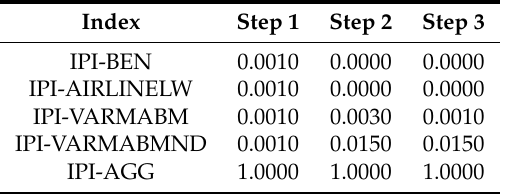
Table 34. Model confidence set hierarchy loss function is the absolute error at the end of the sample α = 0.05, number of bootstrap replications = 5000 and block length = 12.